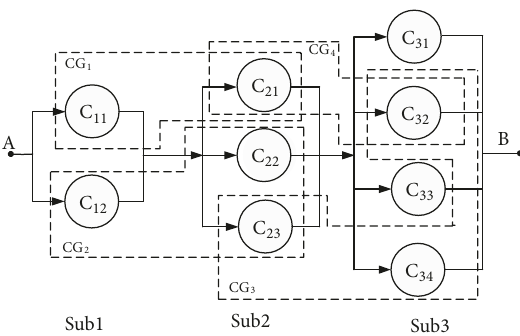
Using (9), the conditional expected system performance level at reliability 𝑅(4)